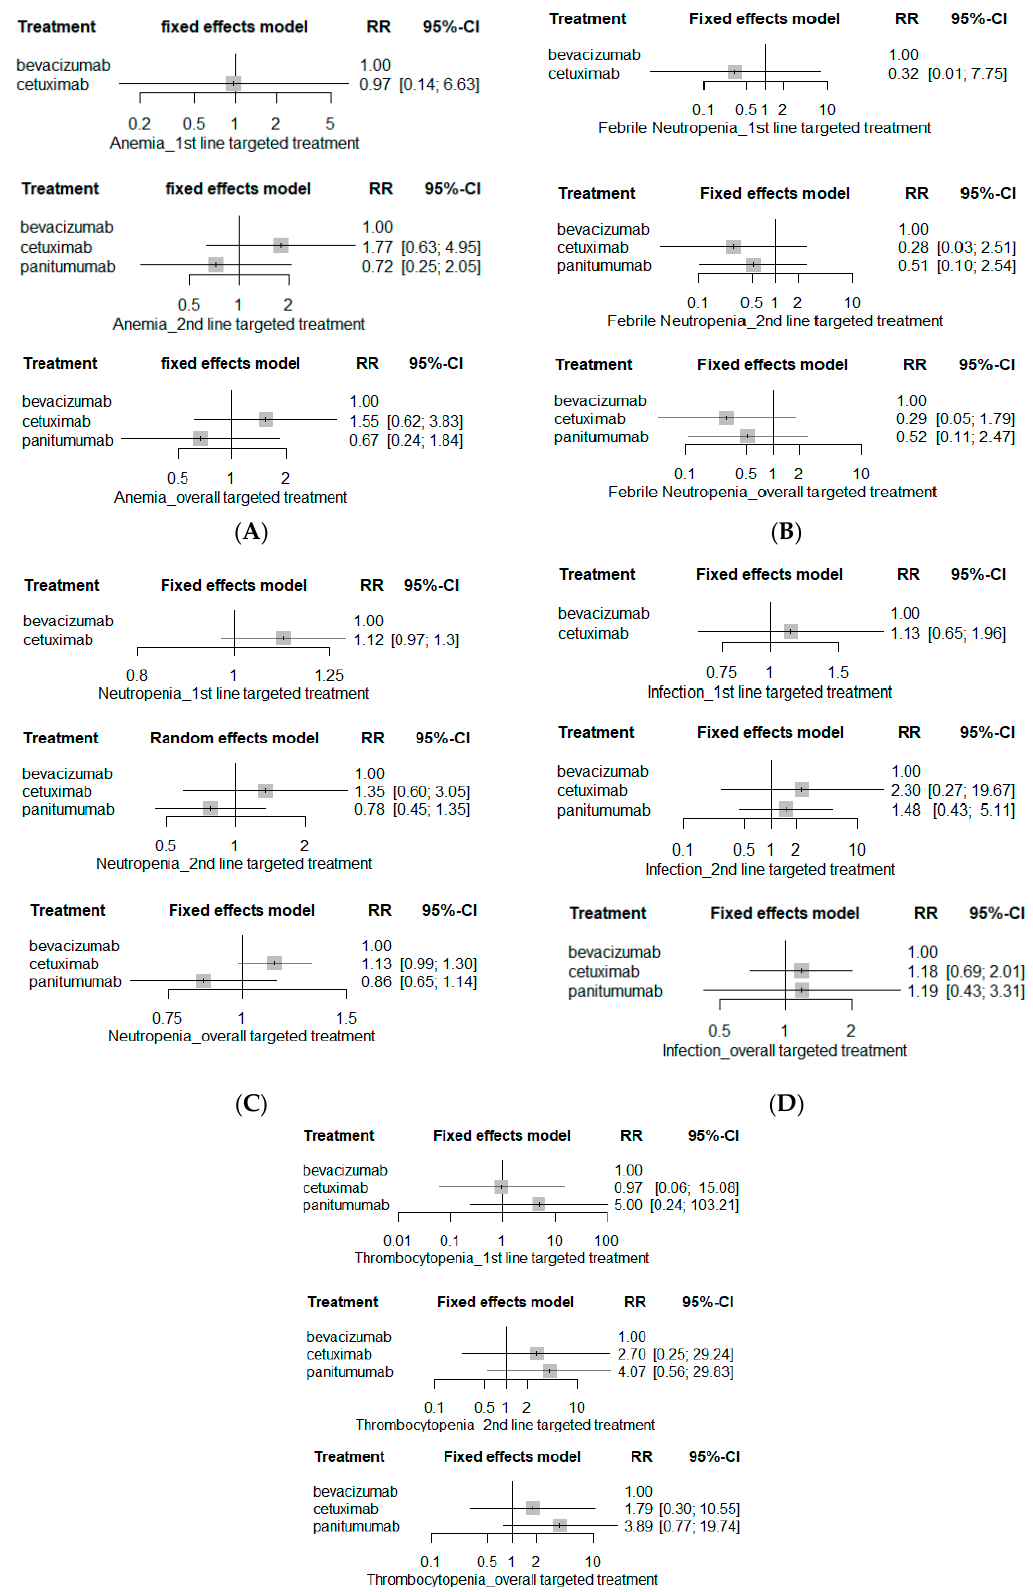
Figure 4. Hematological SAE risks. ( A ) Anemia; ( B ) febrile neutropenia; ( C ) neutropenia; ( D ) infec- tion; and ( E ) thrombocytopenia.